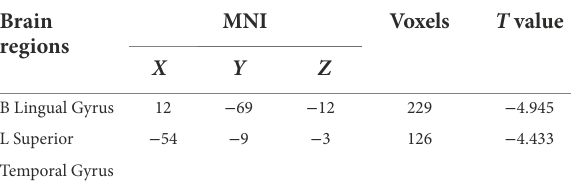
TABLE 2 Altered Reho regions between OSA-MCI and OSA-nMCI groups.